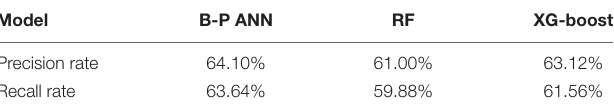
TABLE 7 | Comparison of machine learning model results.